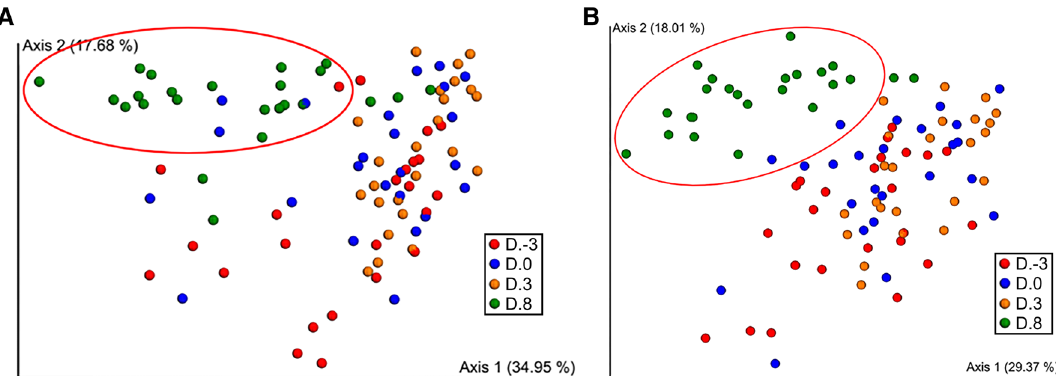
Figure 2. Principal coordinates analysis (PCoA) plot of antimicrobial resistance determinants obtained from piglets at day 3 pre-weaning (D. − 3), weaning day (D.0), days 3 (D.3) and 8 post-weaning (D.8). The oval shows a D.8 sample group that is separated from. D. − 3–D.3 groups. Taxonomic abundance ( A ). AMR gene abundance ( B ). Beta diversity group significance: P value = 0.001, PERMANOVA, 999 permutations.